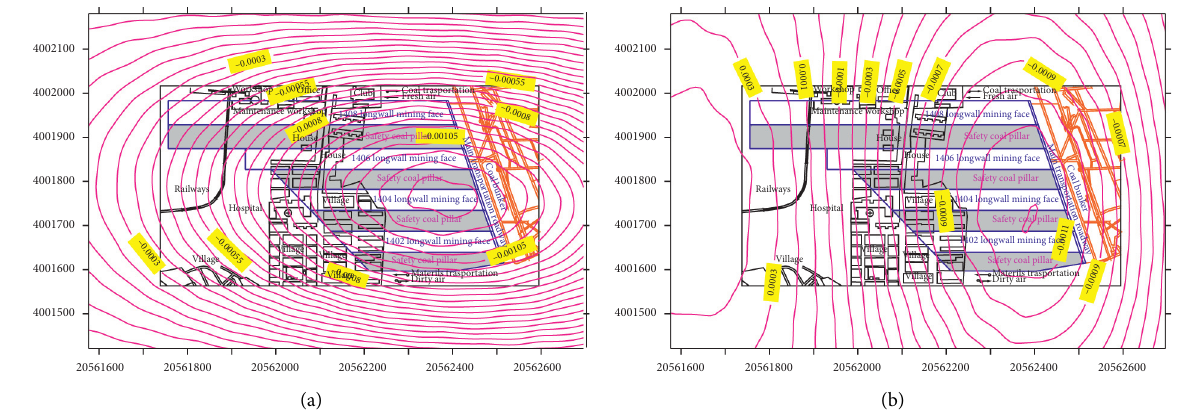
Figure 12: Contour map of surface curvature in strip